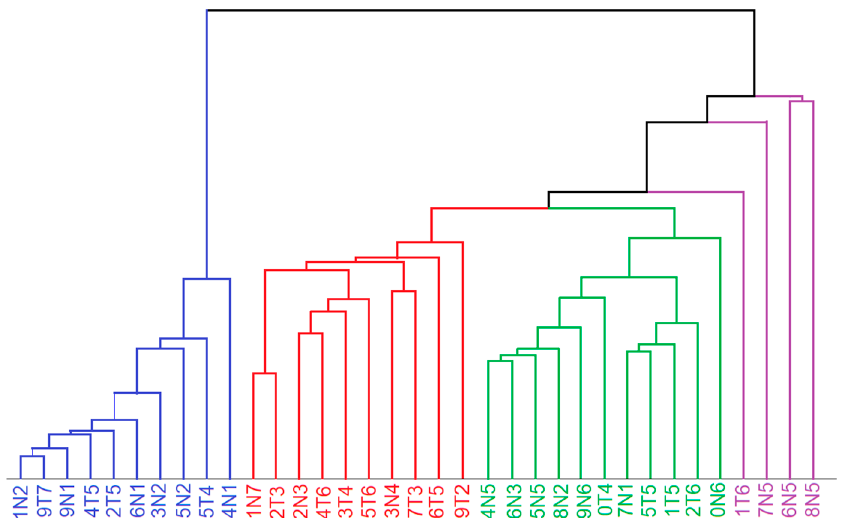
Figure 5. Dendrogram of hierarchical cluster analysis of endmember spectra related to lipids (blue), tumor (red), control and necrosis (green) and epithelium (violet) in the spectral range 800–1380 cm − 1 . Sample nomenclature refer to Table 1.